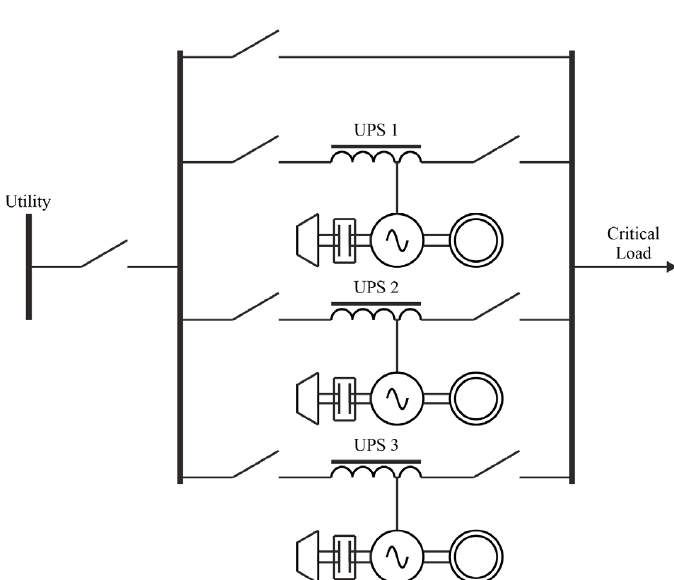
Figure 4. Configuration of Parallel System.